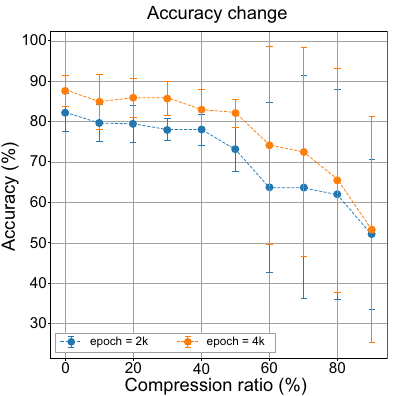
Figure 8. Mean performance change in accuracy of the baseline classifier when the compression ratio for audio embedding increased linearly from 10% to